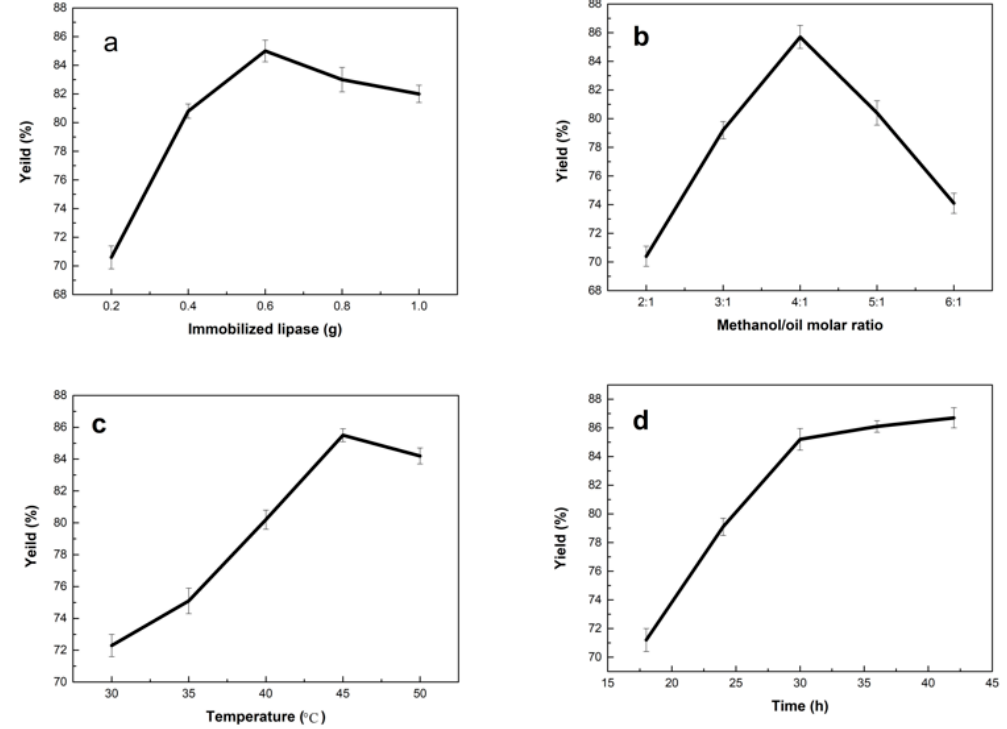
Figure 7. Effects on the transesterification yield: ( a ) immobilized lipase, (conditions: methanol/oil molar ratio, 4:1; temperature, 40 °C; time, 36 h); ( b ) methanol/oil molar ratio, (dose of the immobilized lipase, 0.6g, temperature, 40 °C; time, 36 h); ( c ) temperature, (dose of the immobilized lipase, 0.6 g; methanol/oil molar ratio, 4:1; time, 36 h); and ( d ) time, (dose of the immobilized lipase, 0.6 g, methanol/oil molar ratio, 4:1; temperature, 40 °C).